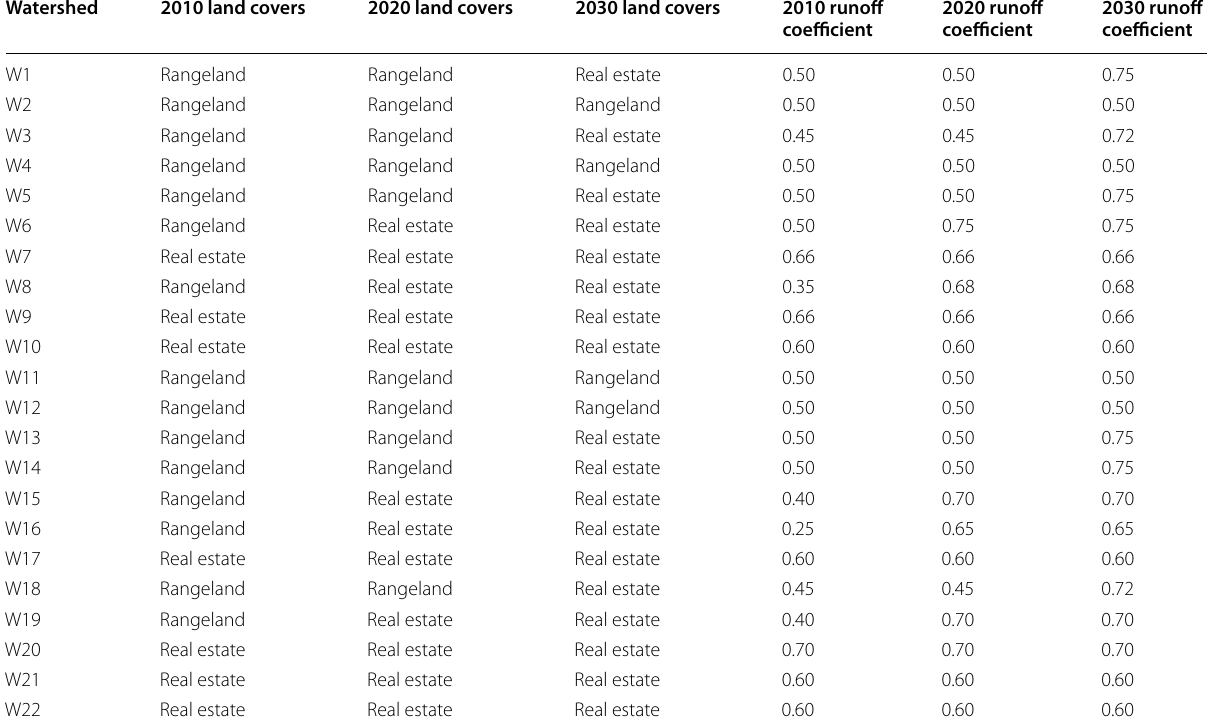
Table 3 Land-use/land-cover expansions and the runoff coefficients (unitless) in the watersheds within three periods of 2010, 2020, and 2030